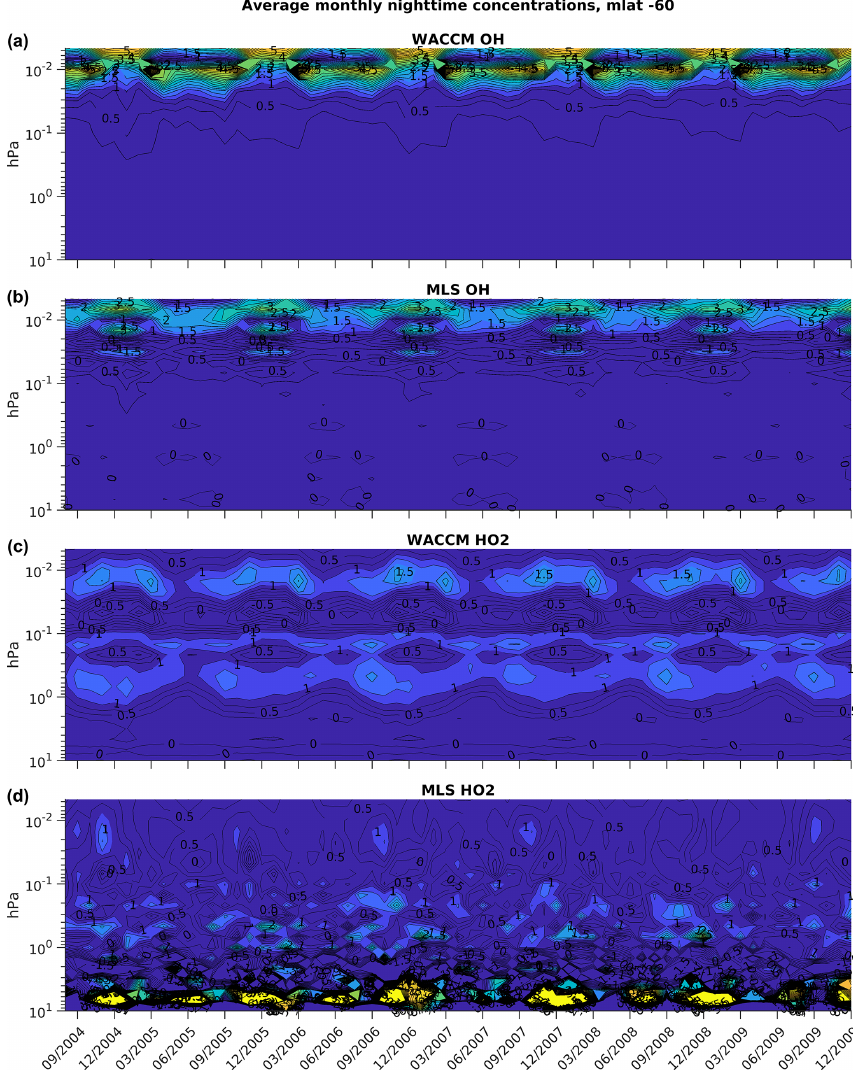
Figure 6. Monthly average nighttime OH and HO 2 concentrations on magnetic latitude 60 ◦ S. From (a) to (d) : WACCM-D OH; MLS OH; WACCM-D HO 2 ; MLS HO 2 . Concentrations are in units 10 6 cm − 3